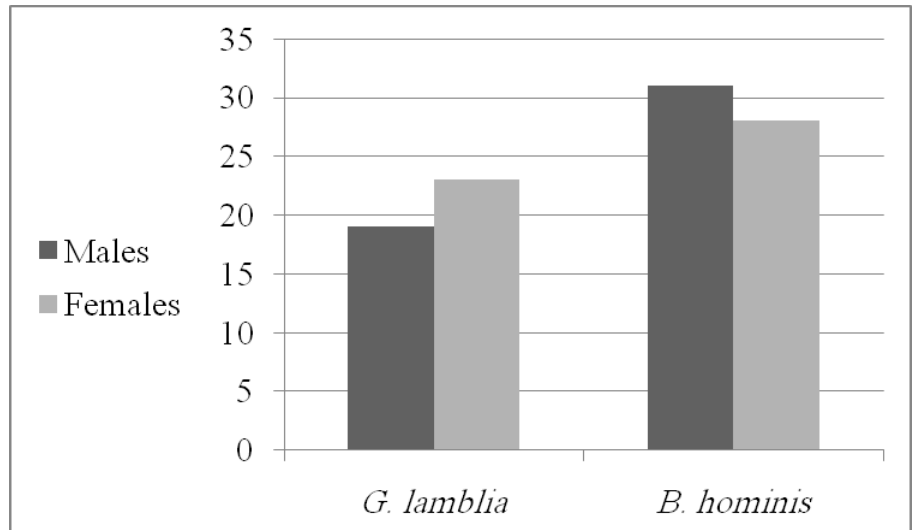
Figure (1): Number of male and female patients infected with G lamblia and B hominis Differences due to sex statistically not significant (p > 005)